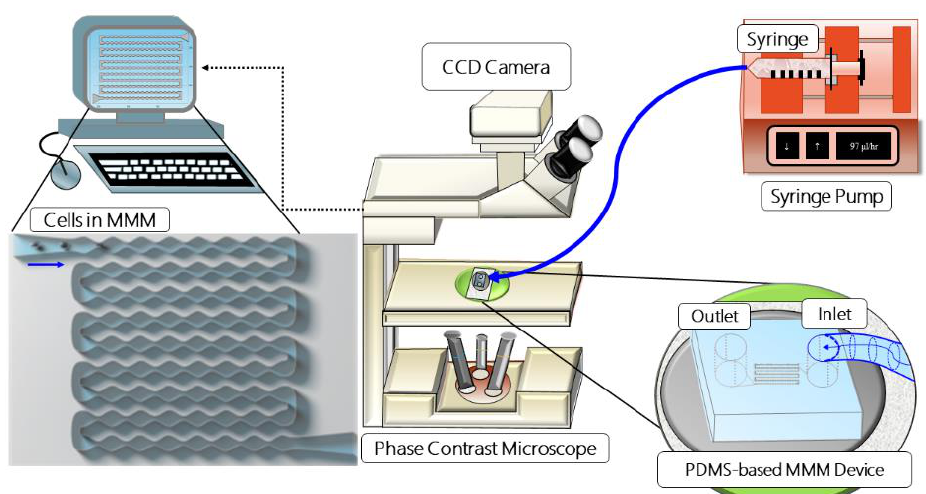
Figure 1. Schematic set-up of the microfluidic microcirculation mimetic (MMM). A suspension of PBS-diluted cells in a syringe is fixed to a syringe pump, connected by tubing to the PDMS-based MMM chip and placed on a phase-contrast microscope equipped with a CCD camera. The camera is connected to a computer which enables the monitoring and running of the device, data collection and analysis.